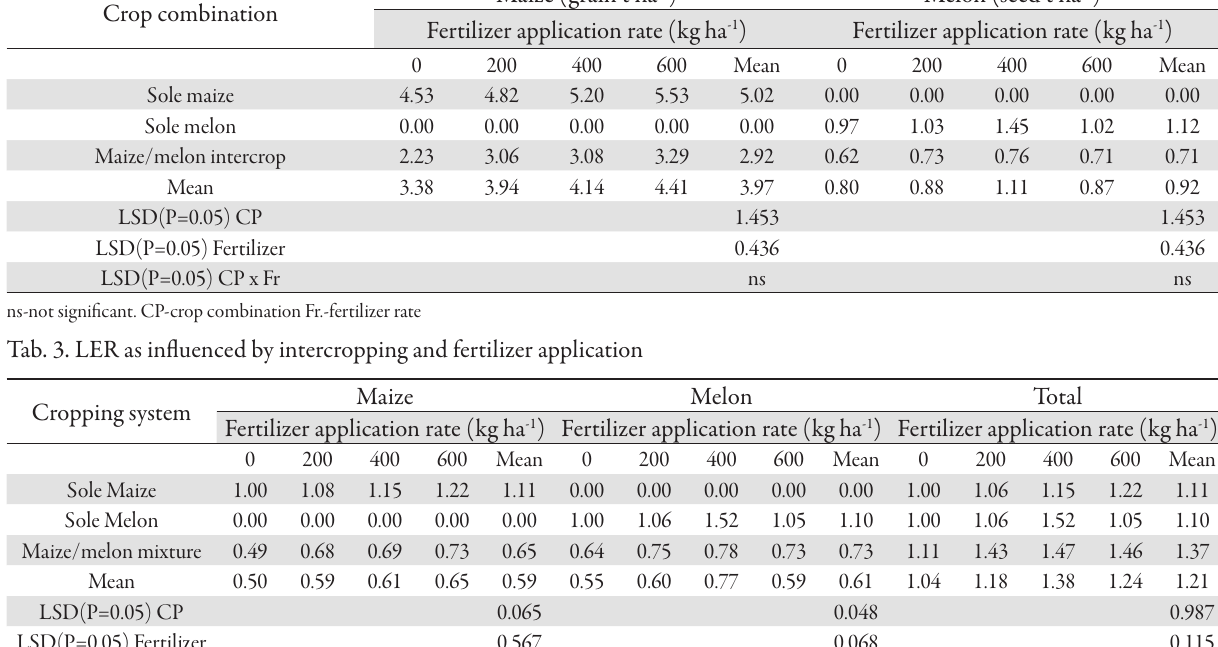
Tab. 2. Economic yield (t ha -1 ) as influenced by intercropping and NPK fertilizer application Crop combination